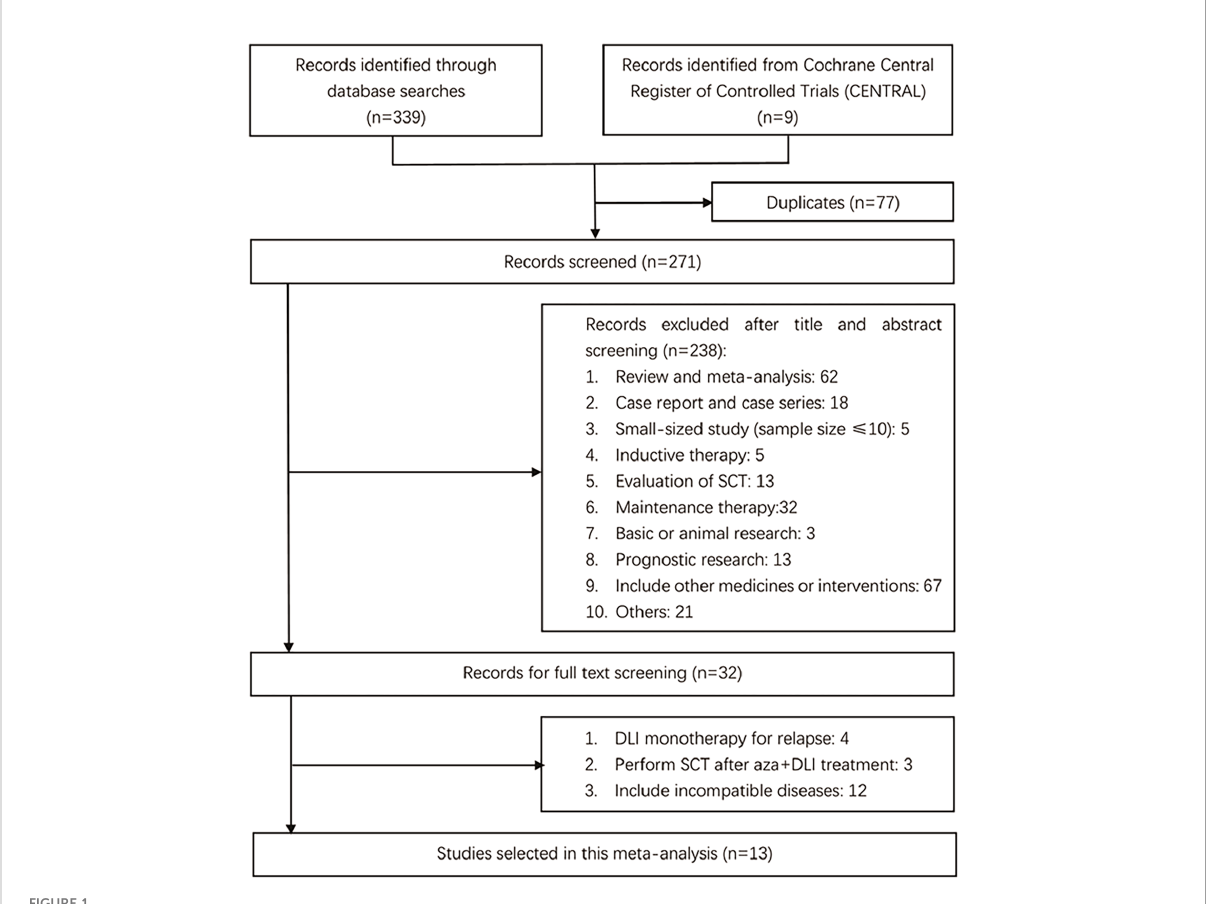
FIGURE 1 Literature search